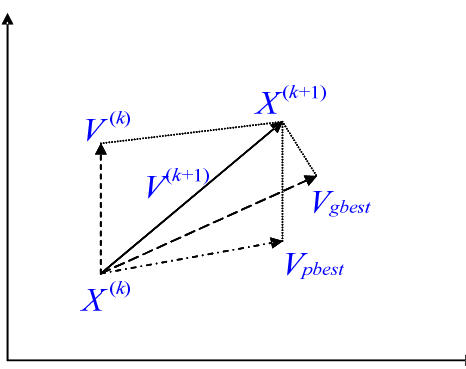
Figure 7. The concept of modification of a searching point by Particle Swarm Optimization (PSO).